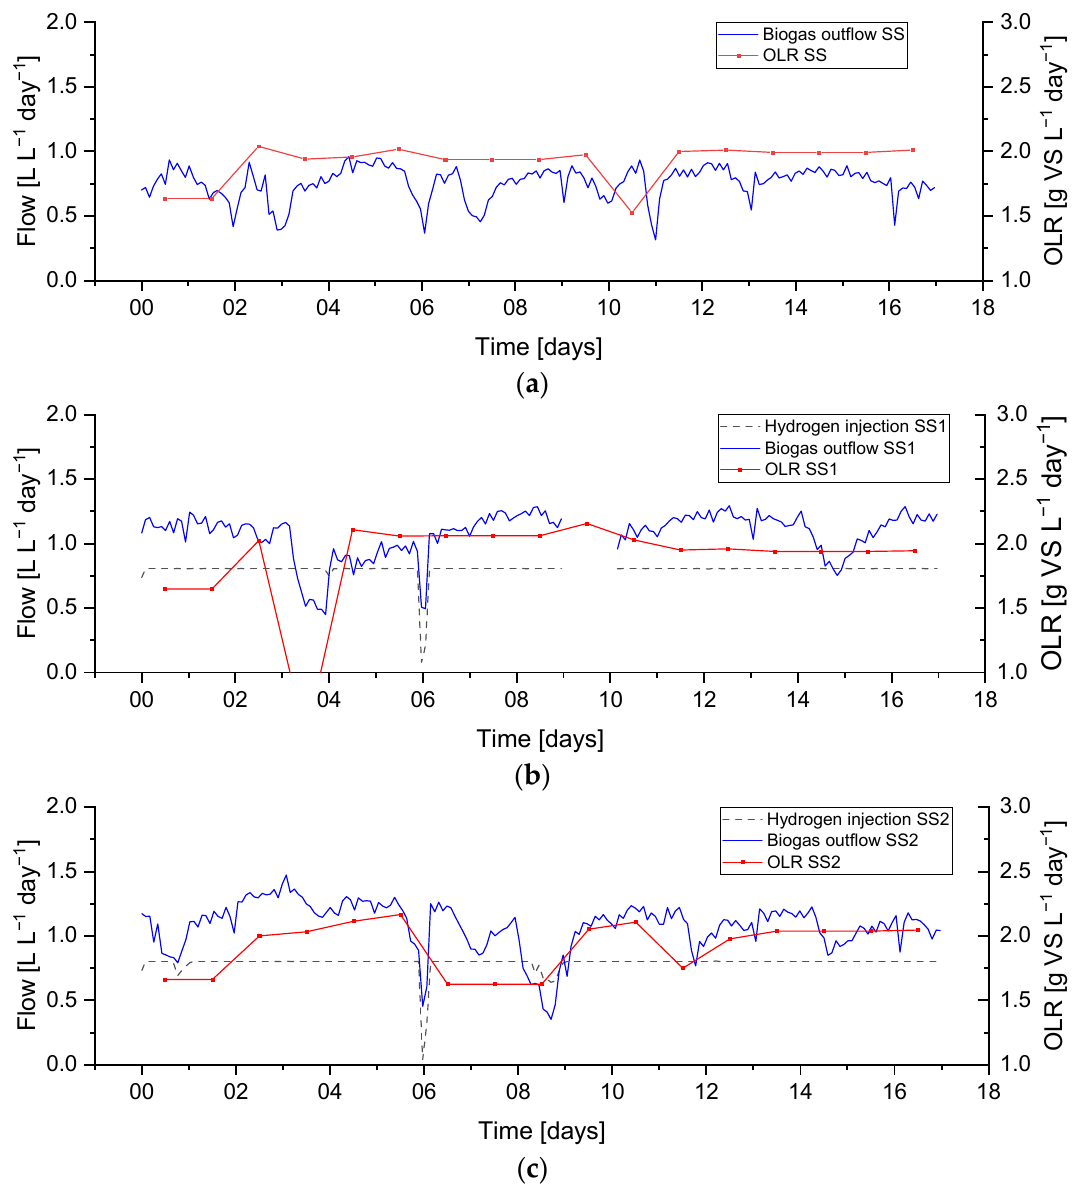
Figure 6. Biogas outflow, OLR, and hydrogen injection rate during period R1 for sewage sludge (SS)-fed reactors : ( a ) Control SS, ( b ) biomethanation reactor SS1, ( c ) biomethanation reactor SS2.